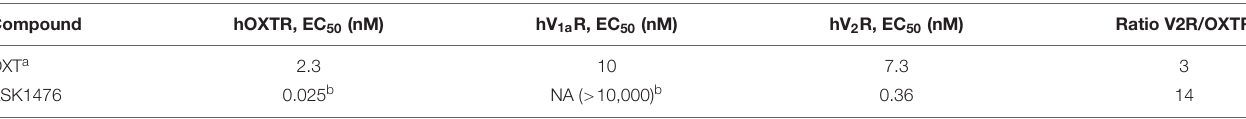
TABLE 1 | Receptor pharmacology data for OXT and ASK1476 (PF1).